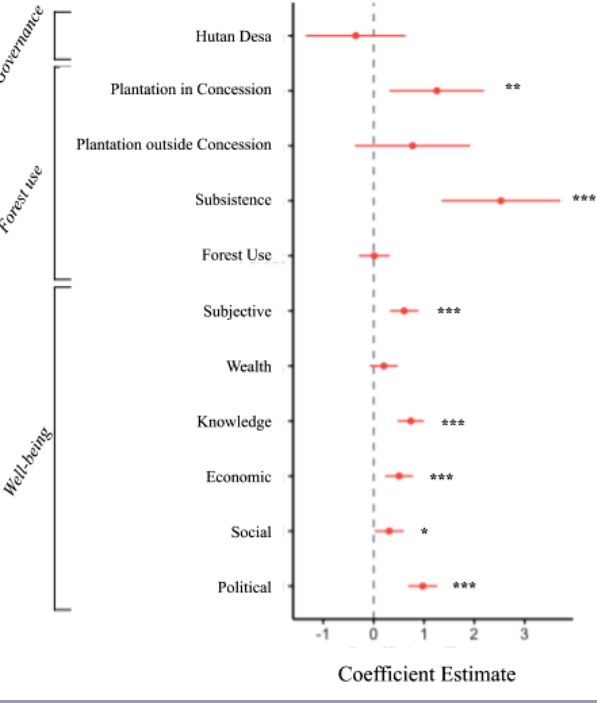
Fig. 4 . Coefficient estimates from cumulative link mixed model with participation level as the response